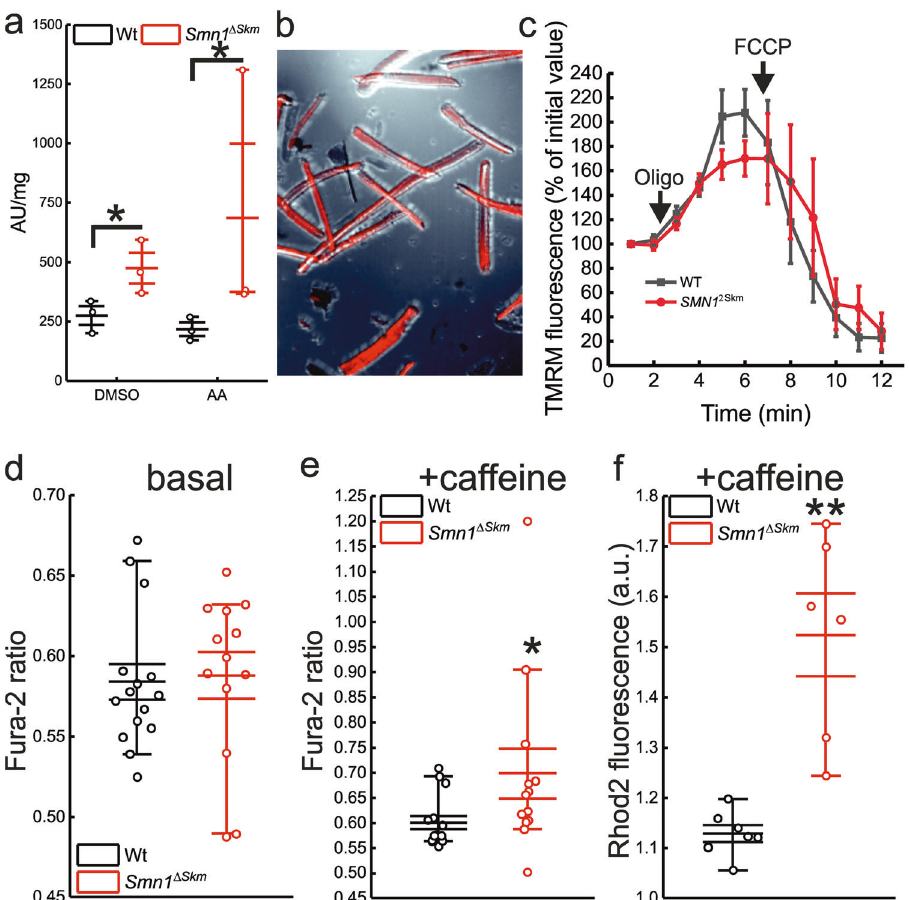
Fig. 5 Loss of SMN in skeletal muscle causes oxidative stress and dysregulated Ca 2 + homeostasis. a Box-dots plots of H 2 O 2 levels in saponin- permeabilized fi ber bundles from TA muscles of Wt and Smn1 Δ Skm mice ( n = 3), without and with addiction of antimycin A (5 μ M). The error bars indicate SEM; * p < 0.05. b Representative fl uorescence image of fi bers isolated from tibialis anterior (TA) muscle following loading with Tetramethylrhodamine, ethyl ester (TMRM, in Red). c The mitochondrial membrane potential of myo fi bres from Wt and Smn1 Δ Skm mice was measured before and after the addition of 5 μ M oligomycin (Frame 2) and 10 μ M FCCP (Frame 5-6). Box-dots plots of basal ( d ) and caffeine-induced ( e ) cytoplasmic Ca 2 + levels in single FDB muscle fi bers from mice of the indicated genotypes ( n = 3). The error bars indicate SEM; * p = 0.02. f Box- dots plots of mitochondrial Ca 2 + levels upon exposure to caffeine in single FDB muscle fi bers from mice of the indicated genotypes ( n = 3). The error bars indicate SEM; ** p =